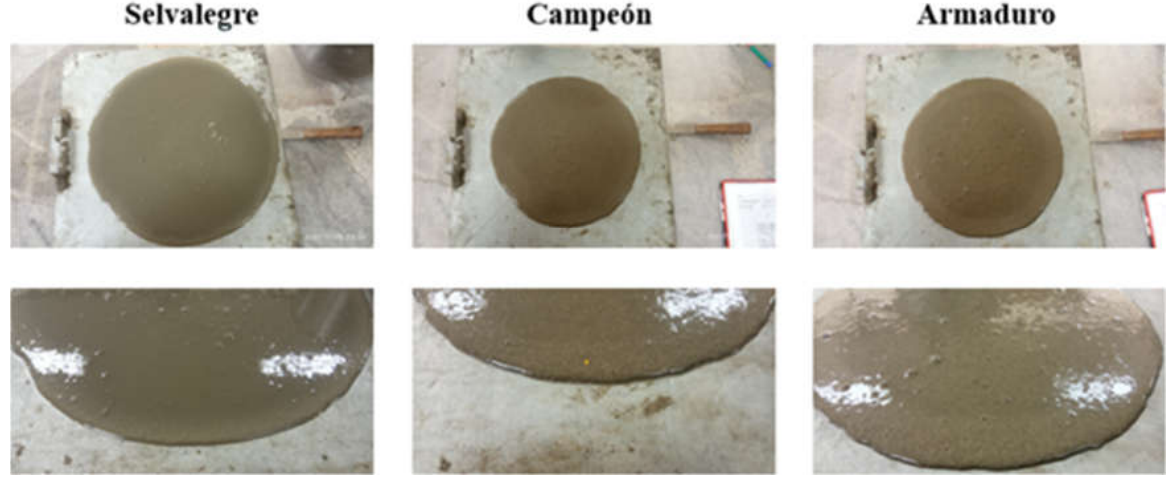
Figure 7. F1-CEM mini-cone results. BS sand. w / c = 0.30. 2.0 % cw